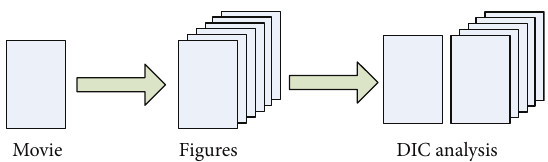
Figure 3: The analysis flowchart of dynamic DIC method.